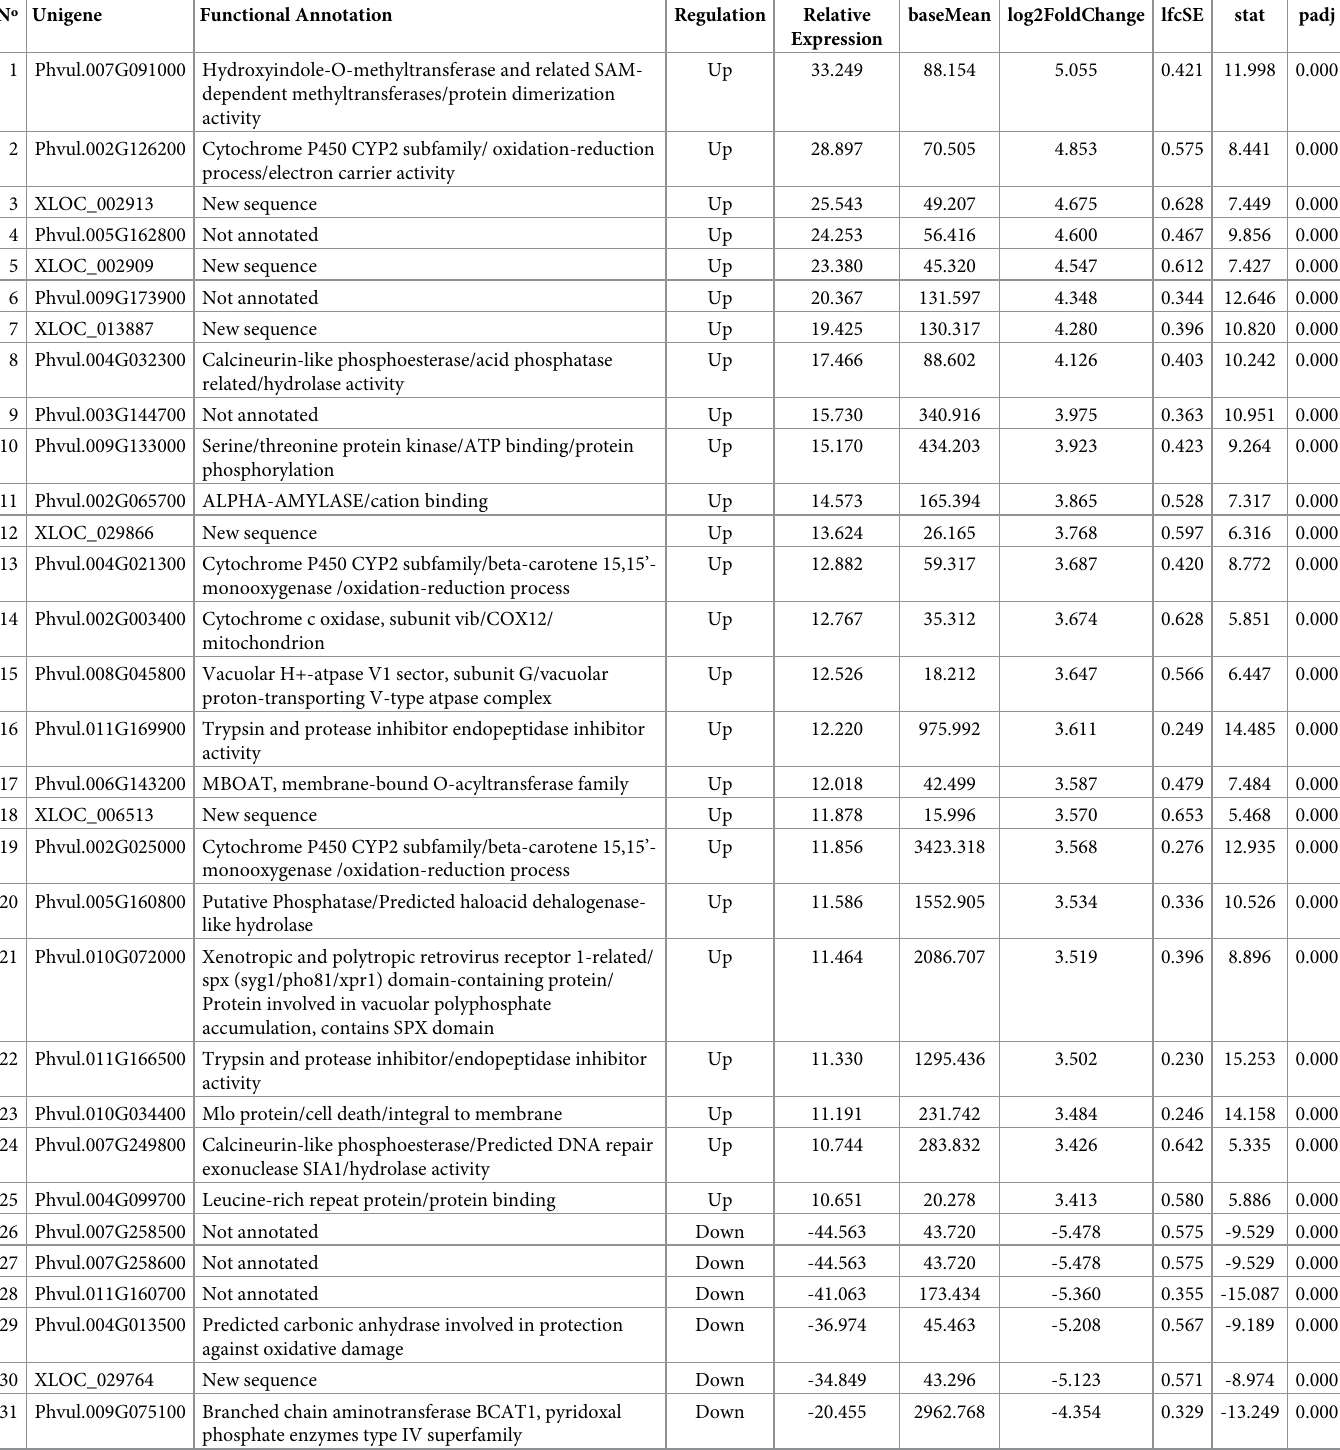
Table 7. Selection of the 25 candidate unigenes most up-regulated and the 25 candidate unigenes most down-regulated of IAC Imperador (decreasing order of log2- FoldChange). From left to right: gene id (Phytozome); annotation of the gene based on blastx search using the database of P. vulgaris (Phytozome) with a cutoff of 1e-10; regulation; relative expression comparing restrictive P vs. control P level; baseMean; log2FoldChange; lfcSE (standard error); padj. N º Unigene Functional